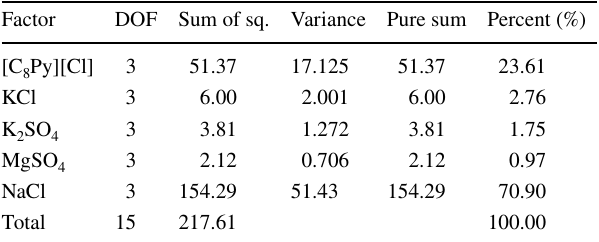
8 Py][Cl] with the presence of KCl, K 2 SO 4 , MgSO 4 and NaCl at different Table 7 Analysis of variance (ANOVA) under the effect [C 8 Py][Cl] IL Factor DOF Sum of